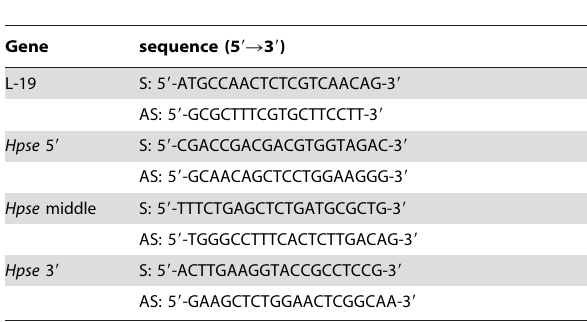
Figure 1. Targeted disruption of the heparanase gene and generation of heparanase deficient mice. A. Structure of the 5 9 end of the heparanase ( Hpse) gene (top-normal allele), the targeting vector (middle- K/O allele), and the expected size of products obtained by digestion with Sca1 or EcoRv (bottom). The orientation of the neo cassette and the southern blot probes are indicated. B. Southern blot analysis. Genomic DNA was extracted from embryos of the intercross of Hpse + / 2 heterozygous mice and subjected to Southern blot analysis after digestion with ERv. Wild type ( wt ) embryos exhibited only the normal allele, heterozygous embryos exhibited both the normal and the mutated allele, while Hpse- KO mice exhibited only the shorter, KO allele. Samples were hybridized with the external probe 3, shown in A. C. Heparanase mRNA expression. RNA was extracted from lungs and spleens of wt and Hpse- KO mice and subjected to PCR analysis of heparanase expression using 3 different PCR primer pairs designed to amplify different regions of the Hpse gene, as indicated. Heparanase expression was identified in samples derived from wt but not from Hpse- KO mice. D. Heparanase activity. Blood samples derived from 4 wt and 4 Hpse- KO mice, as well as total cell lysate derived from JAR cells, were incubated (16 h, 37 u C, pH 6.2) with sulfate labeled ECM. Labeled degradation products released into the incubation medium were subjected to gel filtration analysis on Sepharose 6B, as described in ‘‘Materials and Methods’’. High heparanase activity was noted only in samples derived from wt mice; no heparanase activity was detected in Hpse- KO samples or JAR cell lysate. E. HS degradation. Liver, kidney and spleen tissue extracts derived from wt and Hpse- KO mice were prepared as described in ‘‘Materials and Methods’’ and incubated (18 h, 37 u C, pH 5.8) with 3 H-acetyl labeled HS. The reaction mixture was then subjected to gel chromatography on Superose-12. The upper panel shows blank (peak I; control 3 H-acetyl labeled HS substrate) and positive control (control substrate treated with recombinant heparanase; peak II). Incubations of Hpse -KO tissue extracts (black) resulted in the same elution profile as the blank incubation (upper panel), indicating no detectable heparanase activity. In contrast, incubations